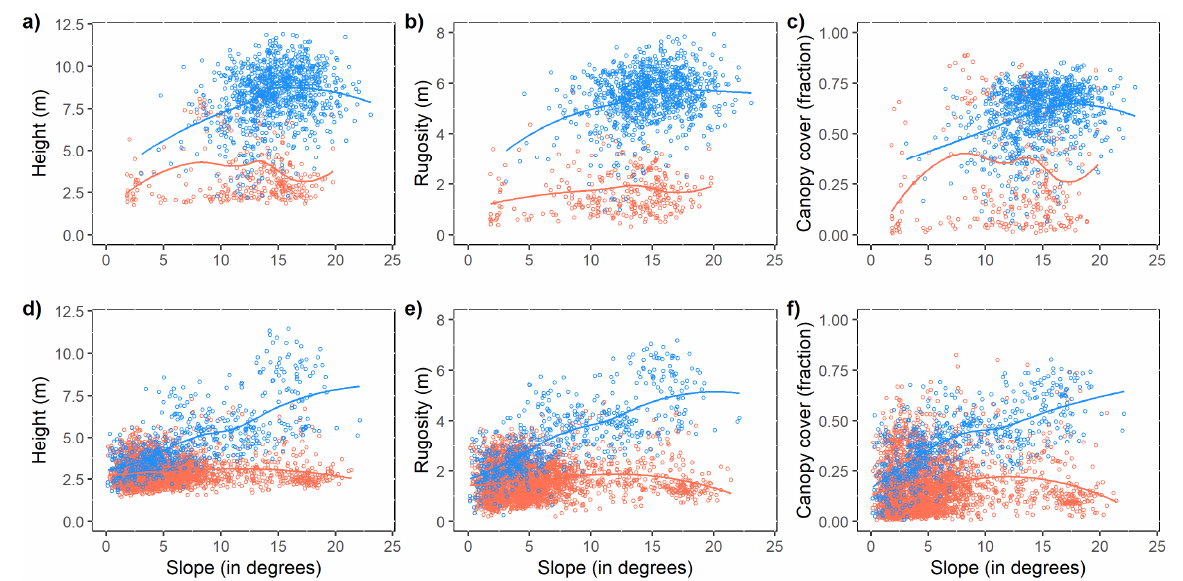
Figure 3. Relationships between different canopy metrics and slope in deciduous and evergreen forests. Different colors indicate tree locations (blue in southern aspects and orange in northern aspects). The LOWESS smoothers indicated by blue and orange lines are for southern and northern aspects, respectively. Sub-plot ( a – c ) are for deciduous forests, while sub-plot ( d – f ) are for evergreen forests.